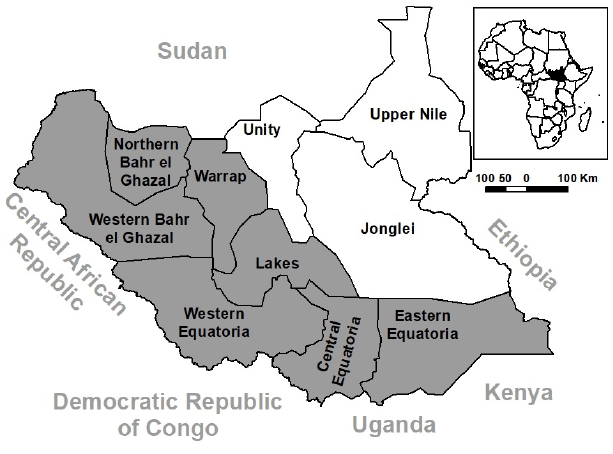
resilience of the population to absorb both natural and human- made shocks and stressors. Fig. 1 . States in South Sudan in 2015 (some boundaries, e.g., with Sudan, are disputed). Fortifying Equality and Economic Diversification (FEED) States are highlighted in